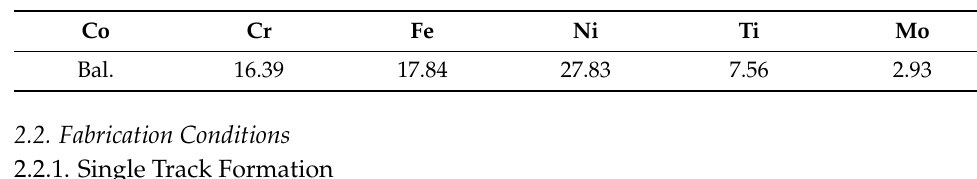
Figure 1. SEM image of HEA powder. Table 1. Chemical composition of HEA (mass%).